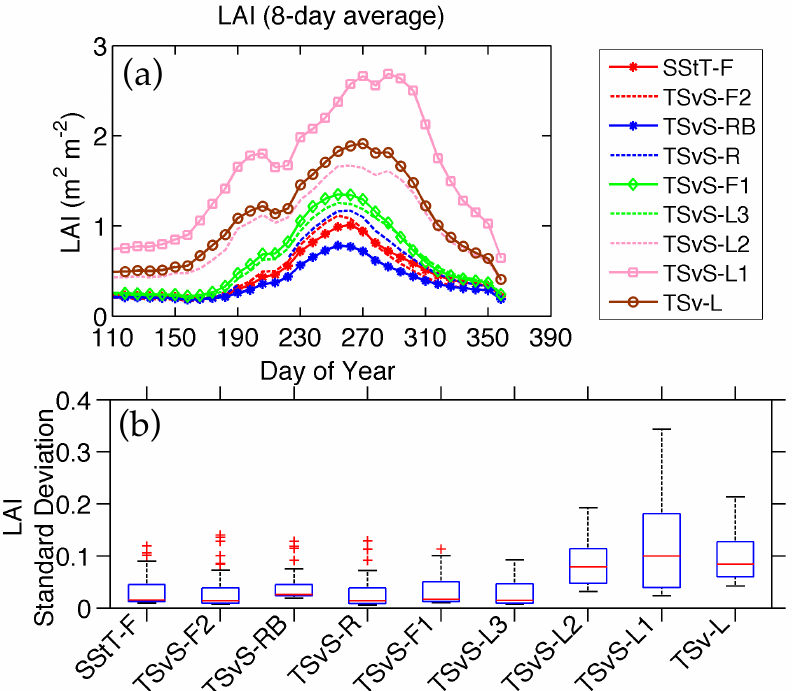
Figure 7. ( a ) Variations of the mean LAI smoothed with the cubic spline, each color representing a homogeneous vegetation-soil zone (VSZ, see Table 3 for legend items); ( b ) into box plot, the standard deviation of LAI (a red segment inside the rectangle shows the median, the “whiskers (black horizontal dash)” above and below the box show the minimum and maximum standard deviation and the blue box around the median is the lower quartile (median value of the lower half of the data) and the upper quartile (median value of the upper half of the data)) for each zone over the 2000–2010